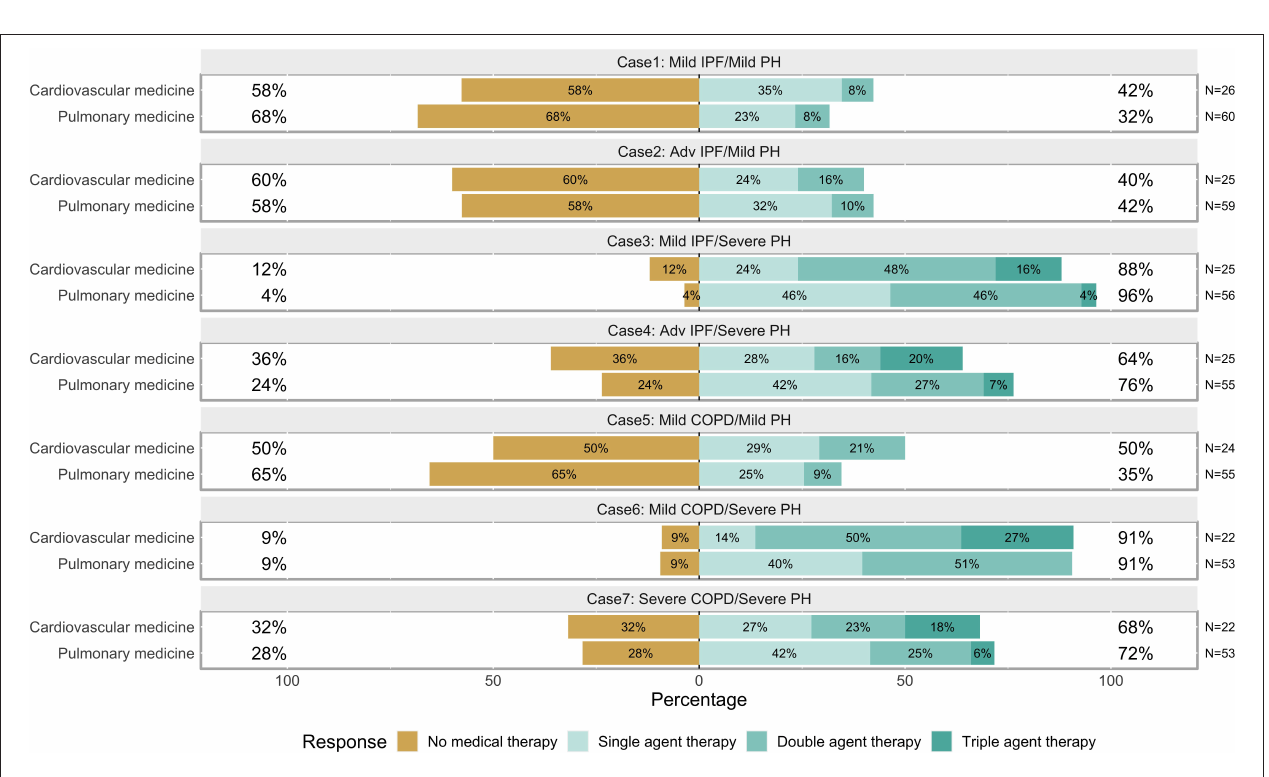
FIGURE 4 | Plot of the responses to each of the seven cases by specialty.